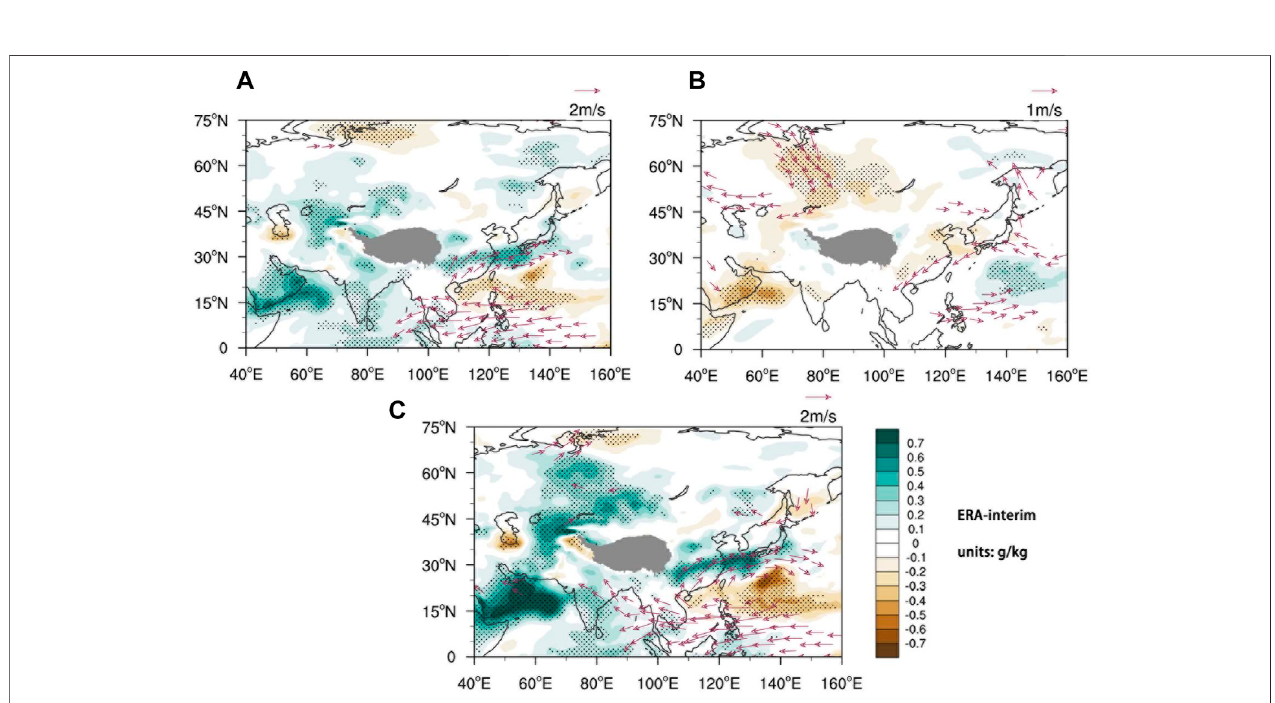
FIGURE 6 | The distributions of background speci fi c humidity at 850 hPa (shadings; units: g/kg; dots are the areas with statistical signi fi cance exceeding the 95% level)andbackgroundwind(vectors;units:m/s;onlylocallystatisticallysigni fi cant( > 95%)vectorsareshown)anomaliesin (A) PHREyearsandin (B) non-PHREyearsas well as (C) the differences between the two during Meiyu